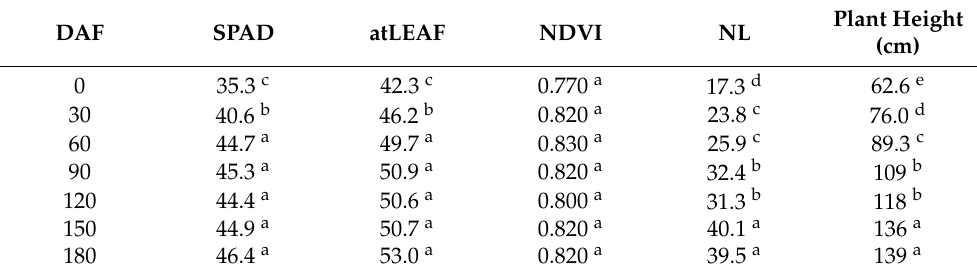
Plant Height (cm)